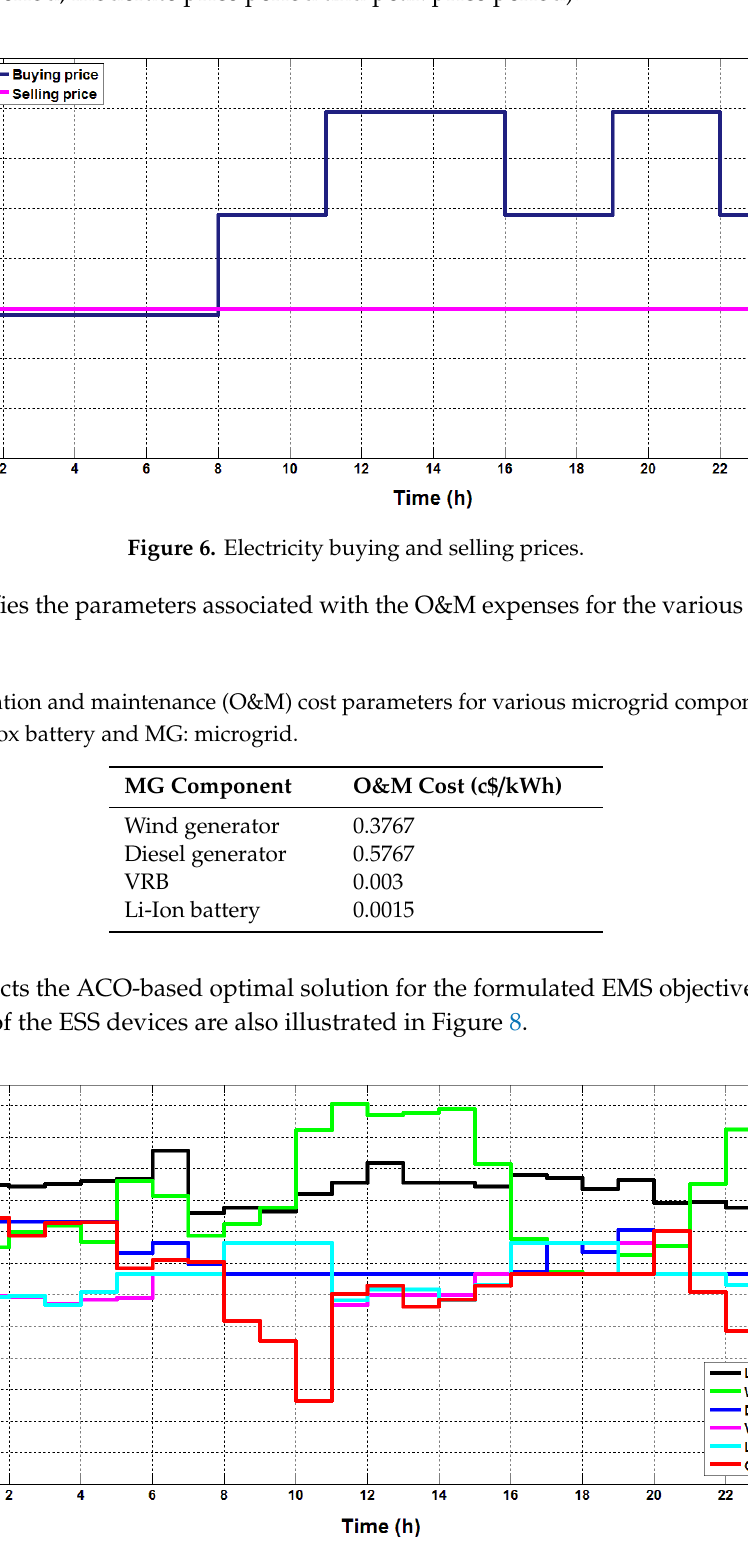
Figure 7. ACO-based optimal EMS solution. VRB: vanadium redox battery.